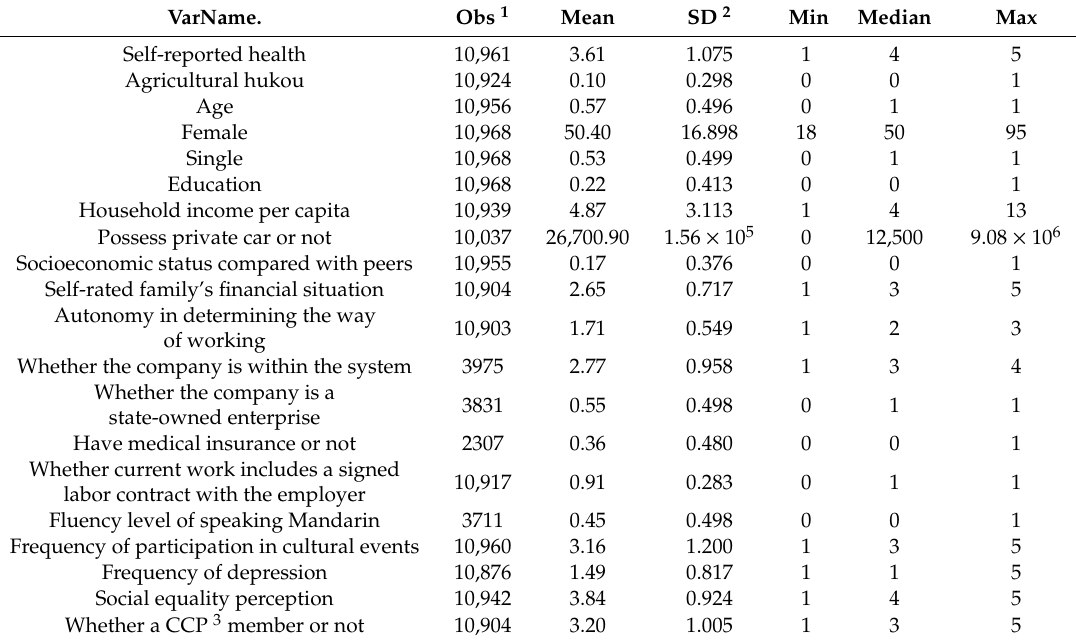
Table 1. Descriptive statistics of key variables.